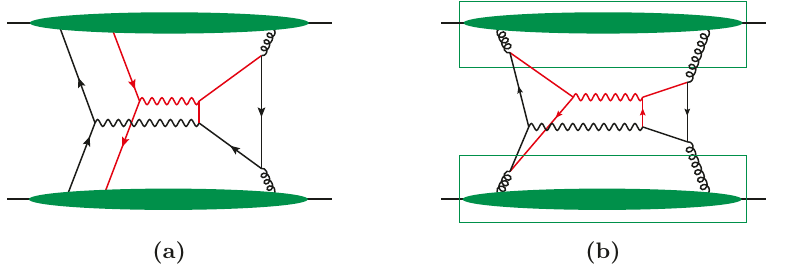
Figure 5. (a) A graph for the SPS/DPS interference that does not have overlap with DPS. (b) An SPS graph that has no overlap with DPS but with the SPS/DPS